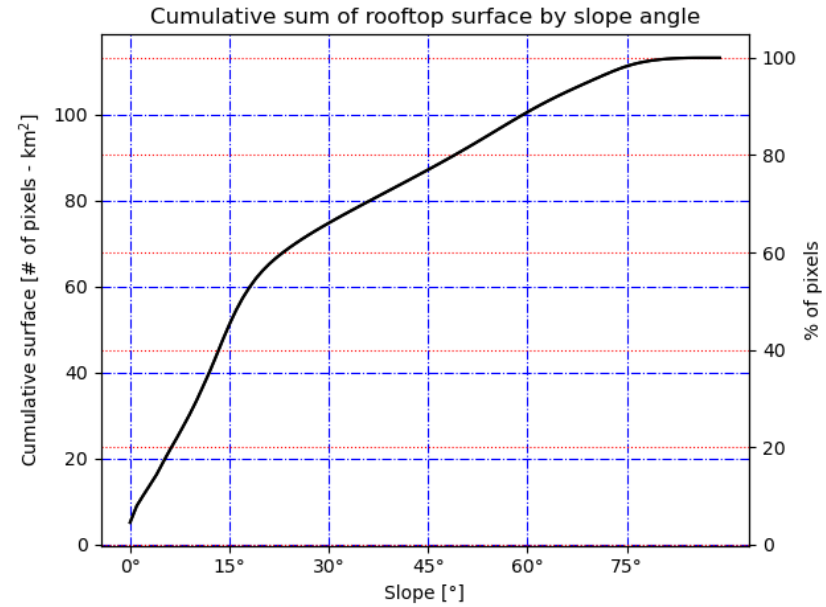
Figure 7. Cumulative sum of rooftop surface, sorted by increasing tilt